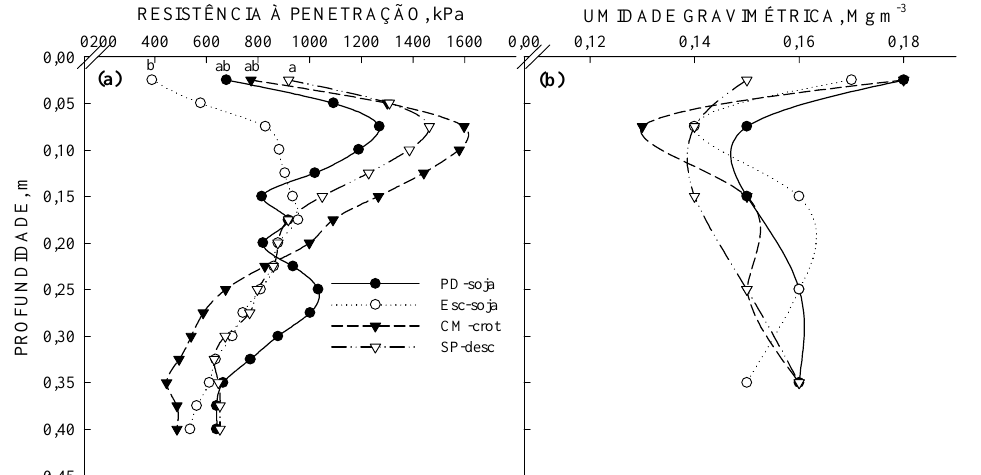
Figura 1. Resistência mecânica à penetração (a) e umidade gravimétrica (b) do solo na profundidade de 0-0,40 m em solo sob diferentes sistemas de